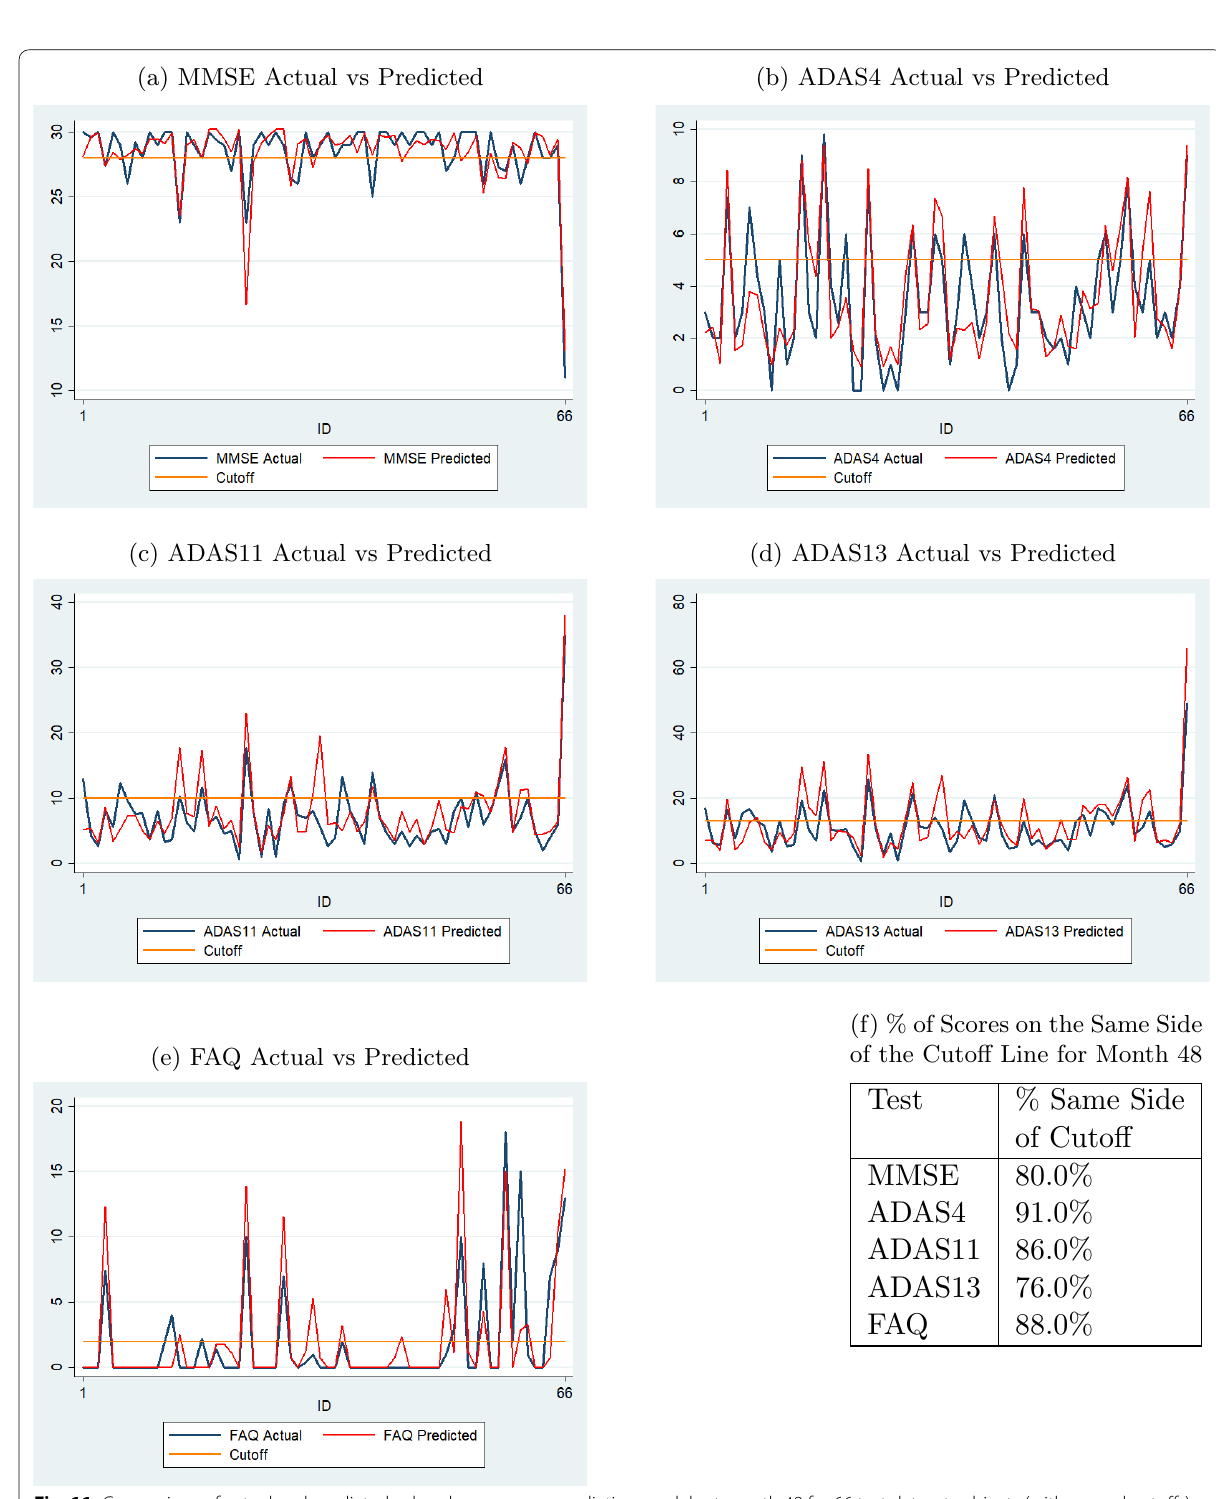
Fig. 11 Comparison of actual and predicted values by sequence prediction models at month 48 for 66 test dataset subjects (with normal